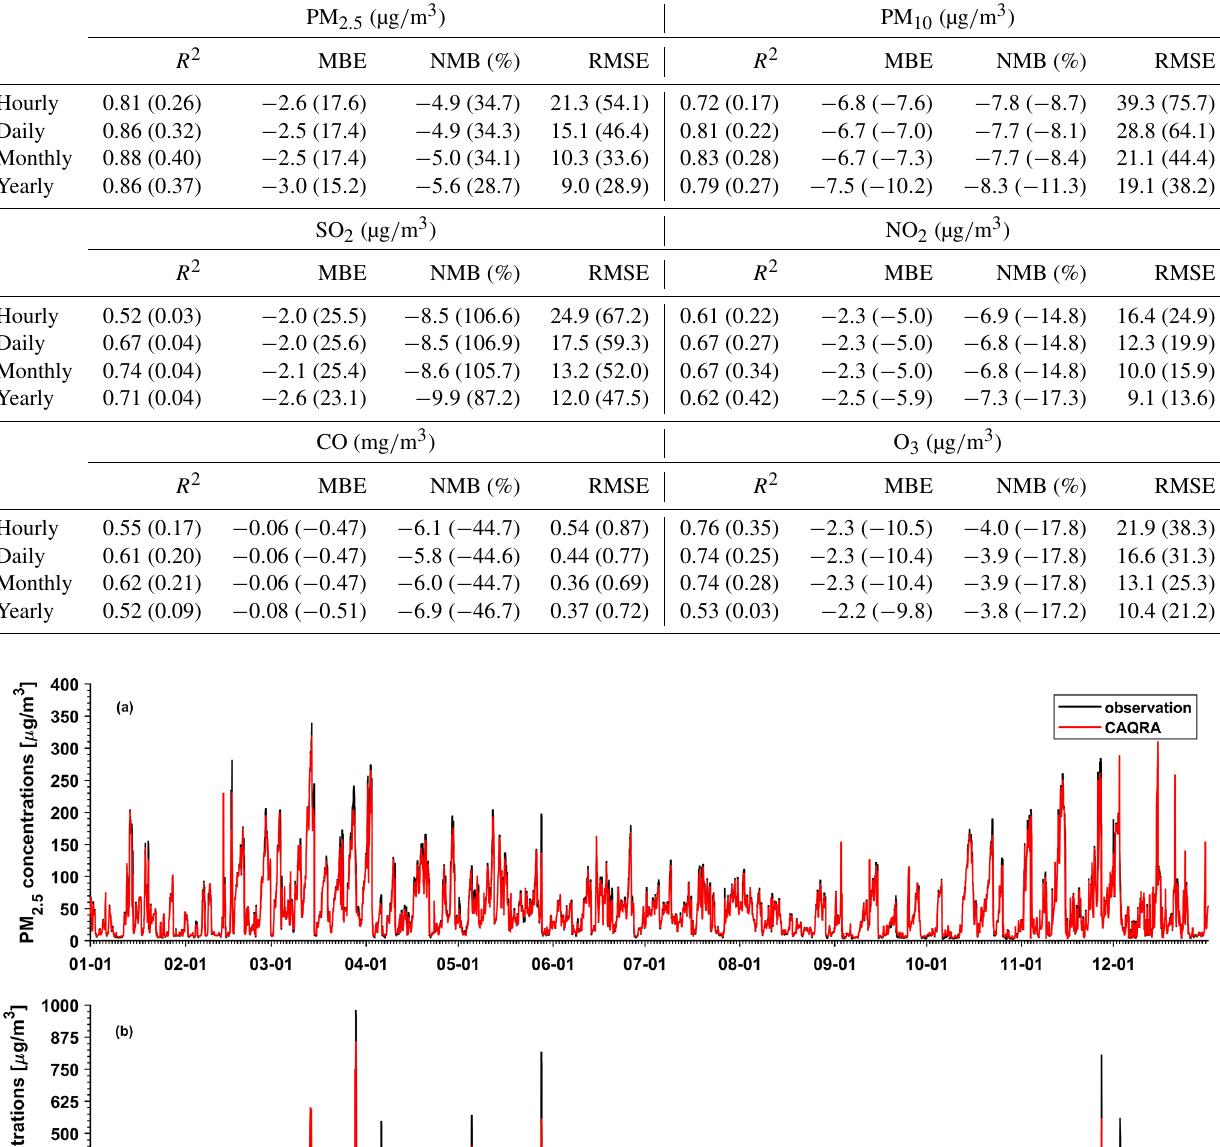
Table 2. Site-based cross-validation results for the reanalysis data (outside brackets) and base simulation (inside brackets) from 2013 to 2018 on the different temporal scales.